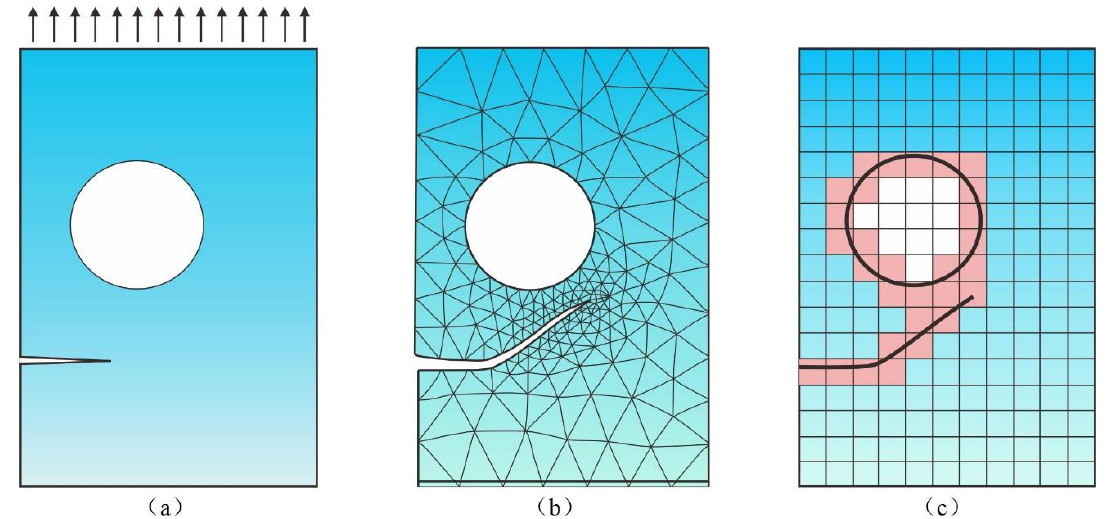
Figure 4. Differences between the traditional finite element method and the extended finite element method when modeling [95]: ( a ) Crack propagation in a flat plate containing holes, ( b ) Finite element meshing using mesh reconstruction method, ( c ) XFEM with enhanced technology.